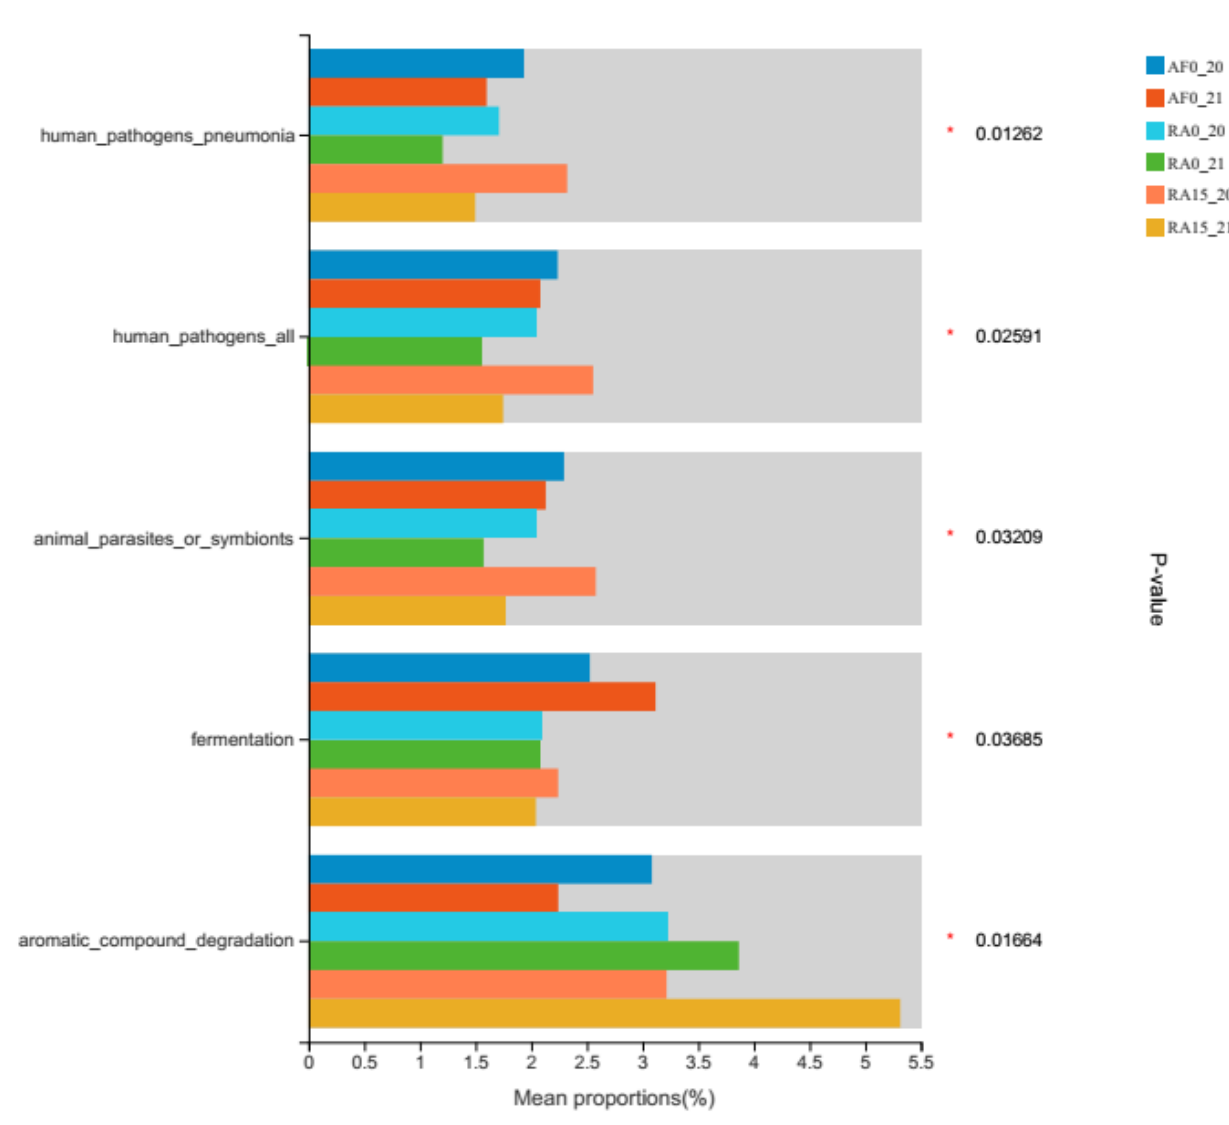
Figure 4. The Kruskal – Wallis test of the bacterial community.